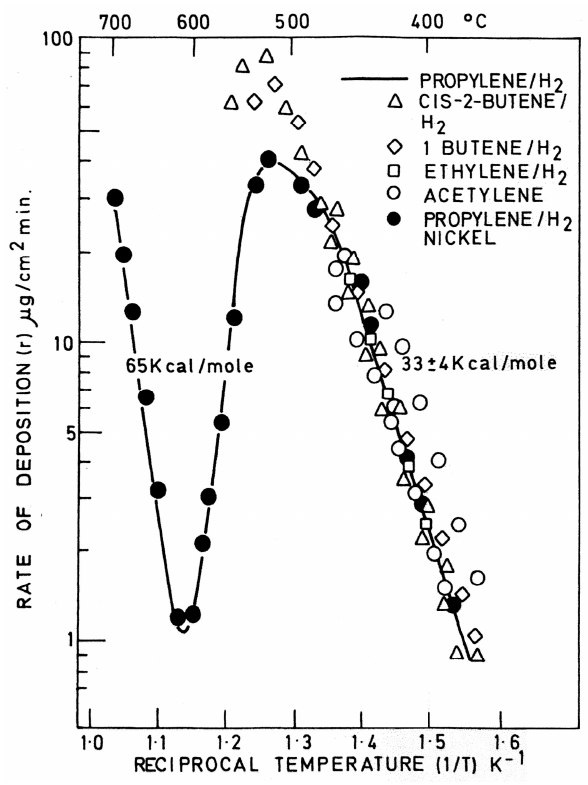
Figure 3. Kinetic curves for the rate of decomposition of carbon against 1/T for hydrocarbons shown (adapted from reference [13]).